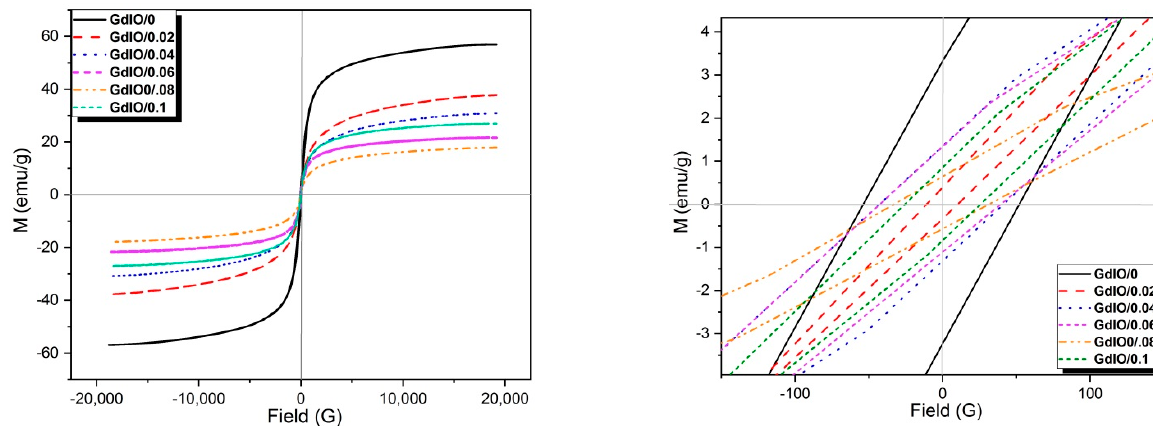
Figure 6. Magnetization curves for samples Gd IO/0, Gd IO/0.02, Gd IO/0.04, Gd IO/0.06, Gd IO/0.08 and Gd IO/0.1 ( left ) and magnetization for the small applied field to show the coercivity of samples ( right ).